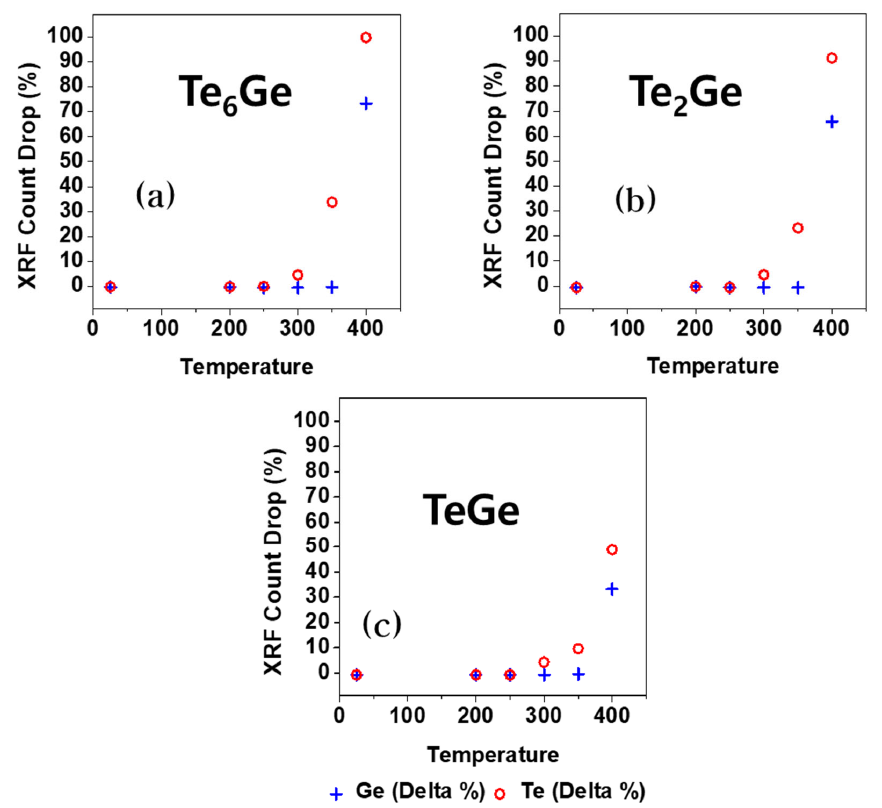
Figure 4. Drop in the XRF count of the OTS device with increasing temperature. ( a – c ) are the Te 6 Ge, Te 2 Ge, and TeGe, respectively.